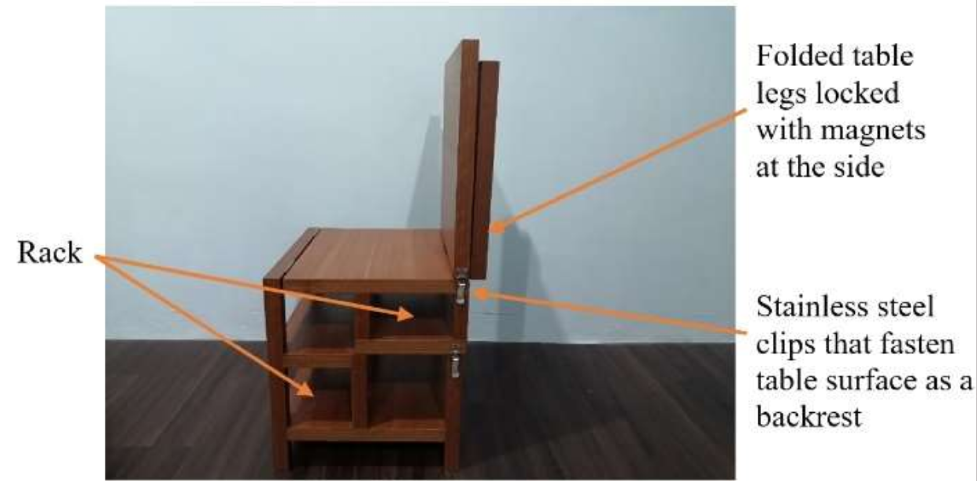
Figure 15. Final prototype—chair